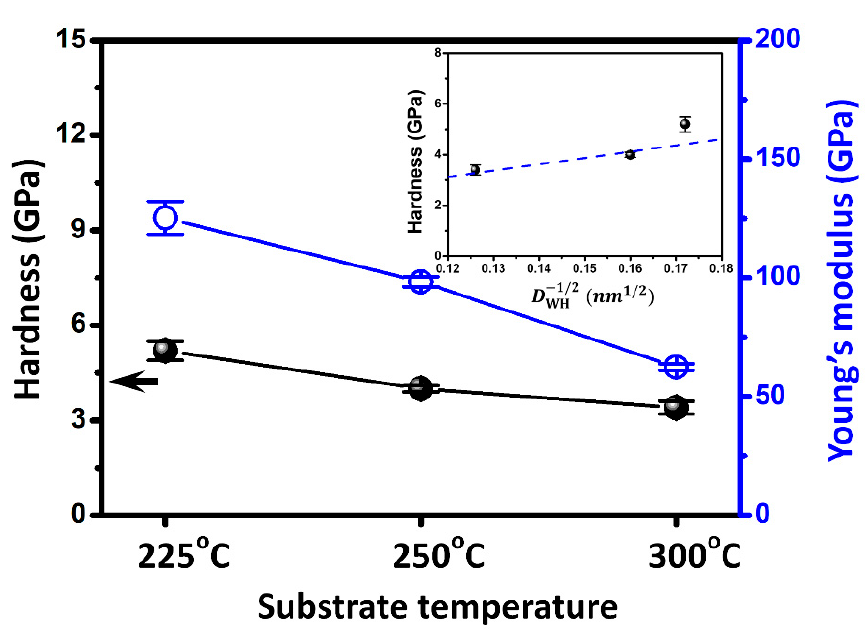
Figure 5. The hardness as a function of grain size for the Bi 2 Te 3 thin films. The dash lines are the fitting using the Hall—Petch equation.